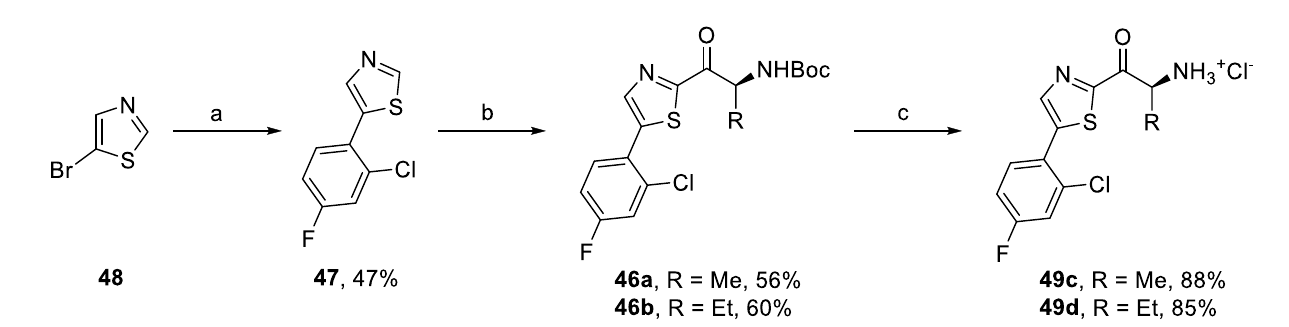
Figure 14. Synthesis of 2-chloro-4-fluorophenyl derivatives 49c,d . Reagents and conditions: (a) 2-chloro-4-fluorophenyl)boronic acid, Pd(PPh 3 ) 4 , K 2 CO 3 , DME/H 2 O, reflux; (b) (i) n -BuLi, THF, -78 C, (ii) 14 or 23e , i- PrMgCl.LiCl, -78 °C; and (c) AcCl, MeOH, 0 °C – r.t.